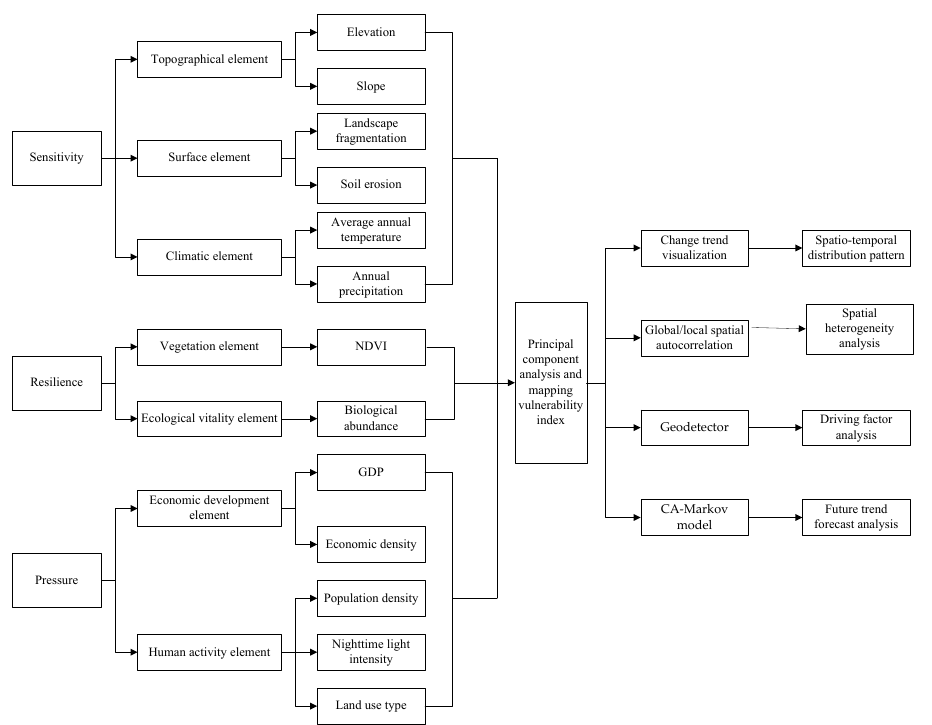
Figure 2. Analysis framework of ecological vulnerability evaluation system.